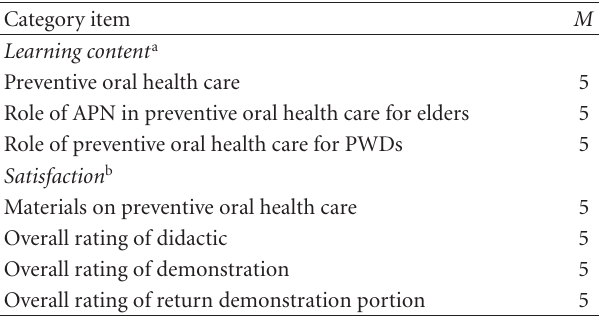
Table 6: Gerontological nurse practitioner anecdotal comments about practicum.